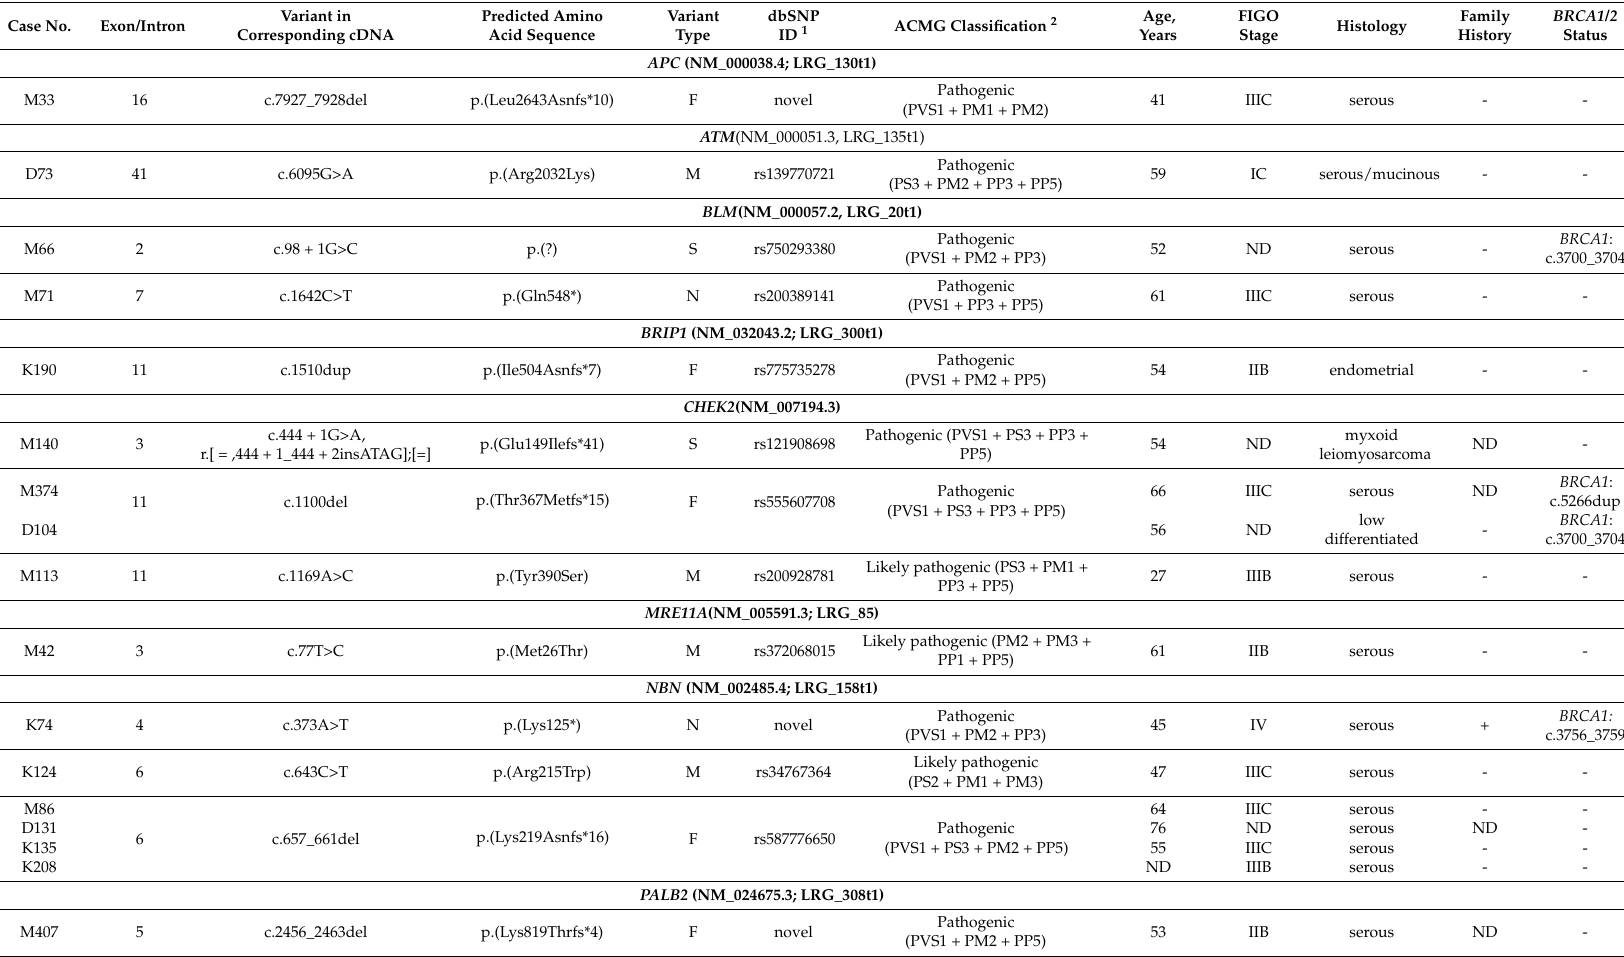
Table 2. Clinical, histopathological and molecular data of the ovarian cancer individuals heterozygous for the pathogenic or likely pathogenic variants in moderate- and low-penetrance